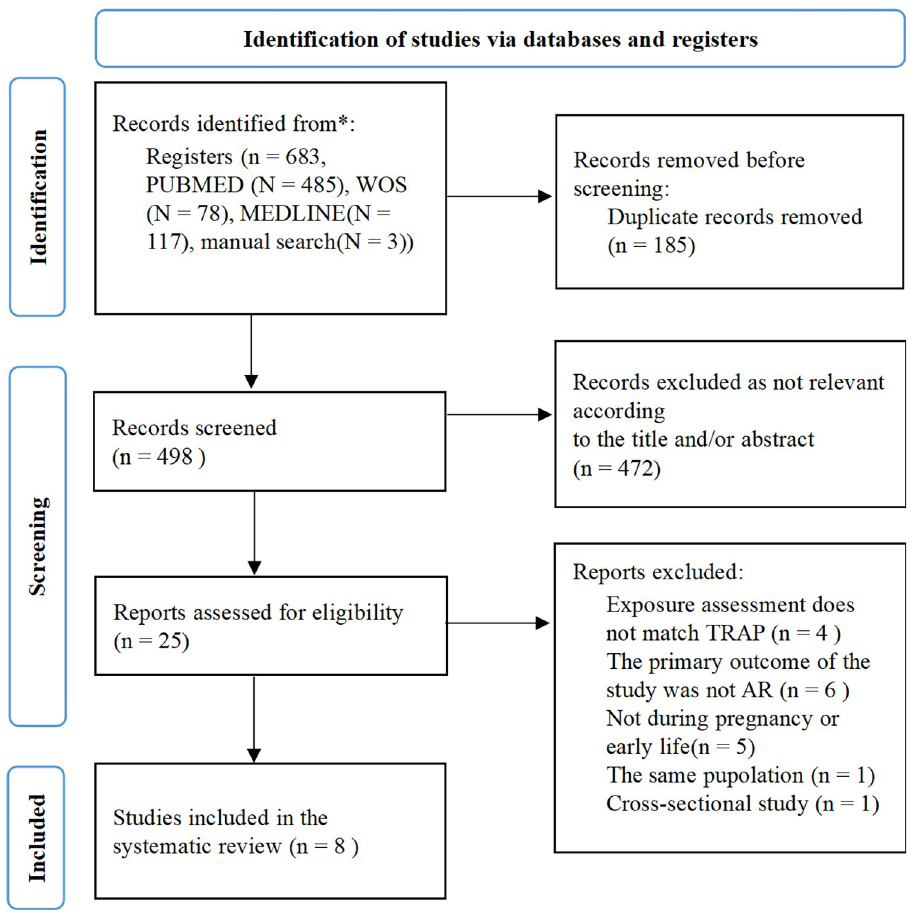
Fig 1. Flow chart of the study